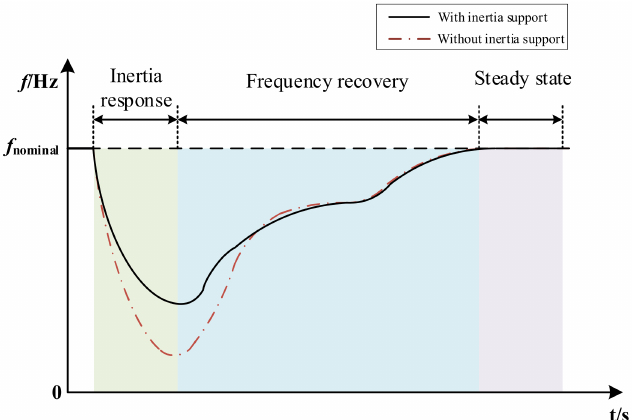
Figure 1. The multi-timescale coordinated frequency response